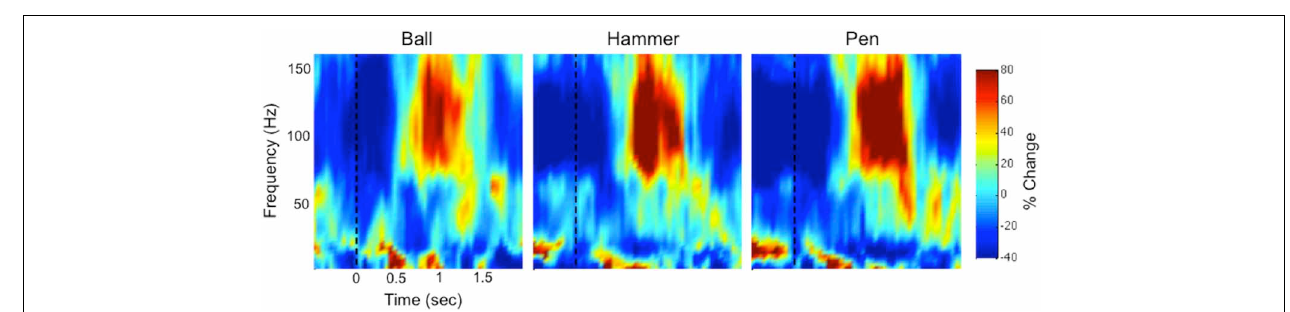
FIGURE 7 | Example time-frequency plot of neural activity (Subject S, electrode #12 as marked in Figure 6) during action observation (AO) of three grasping tasks (Ball, Hammer, Pen). The color indicates normalized spectral power expressed as the percent change from the average activity of